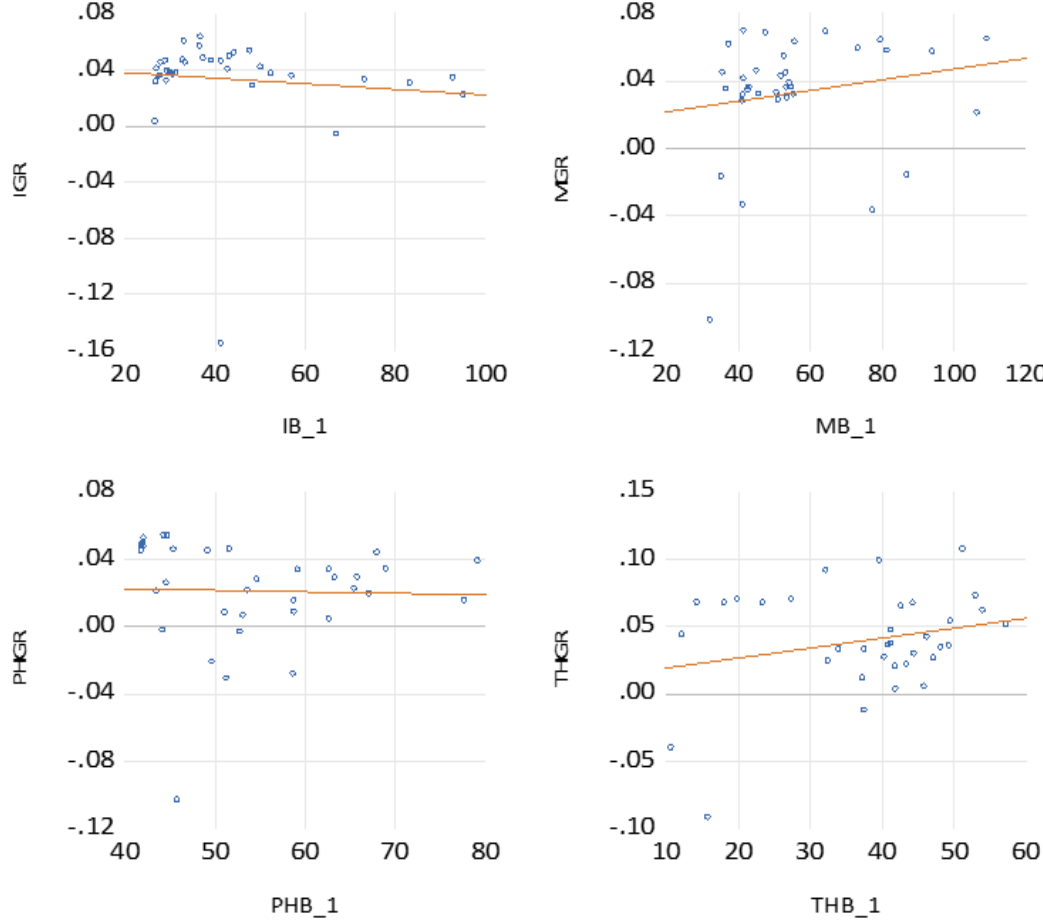
Figure 1: presents the initial debt-GDP growth scatterplot for each country The first left plot shows the pair of data for Indonesia, that has a correlation of -0.109. Next plot refers to the data of Malaysia with a correlation of 0.233. Following plots on the right show data of the Philippines and Thailand with correlation of -0.058, and 0.263, respec -